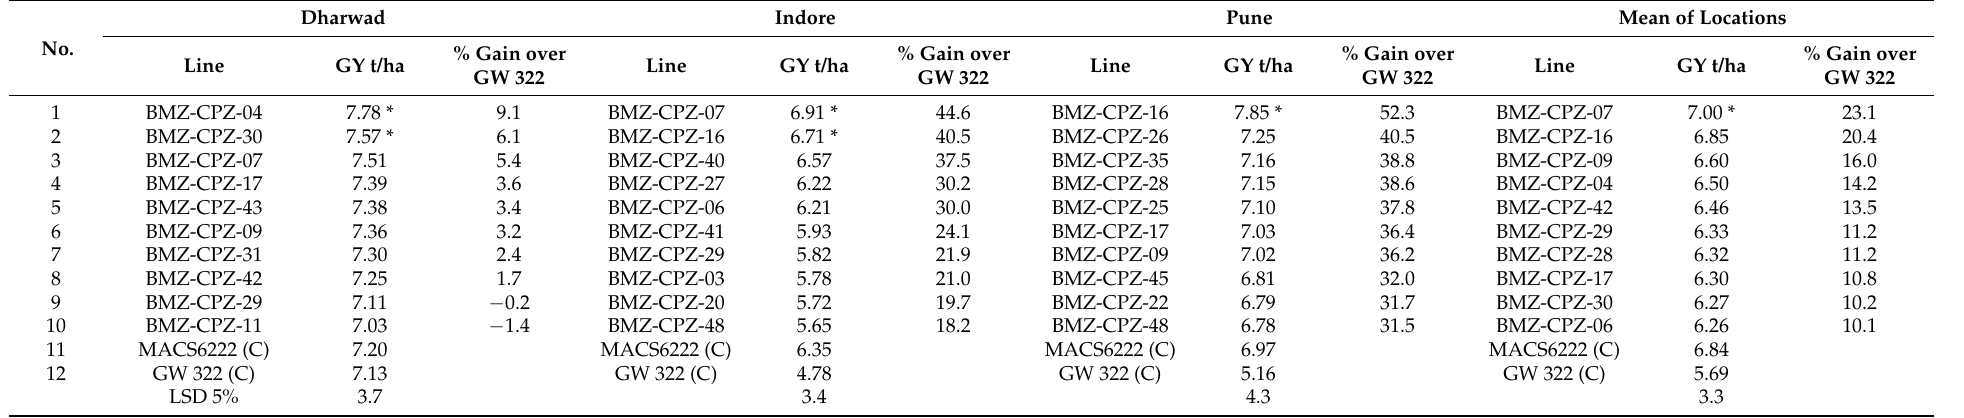
Table 6. Performance of genotypes for grain yield under early sowing in 2013–2014 in three locations of the Central and Peninsular Plains Zone of India.